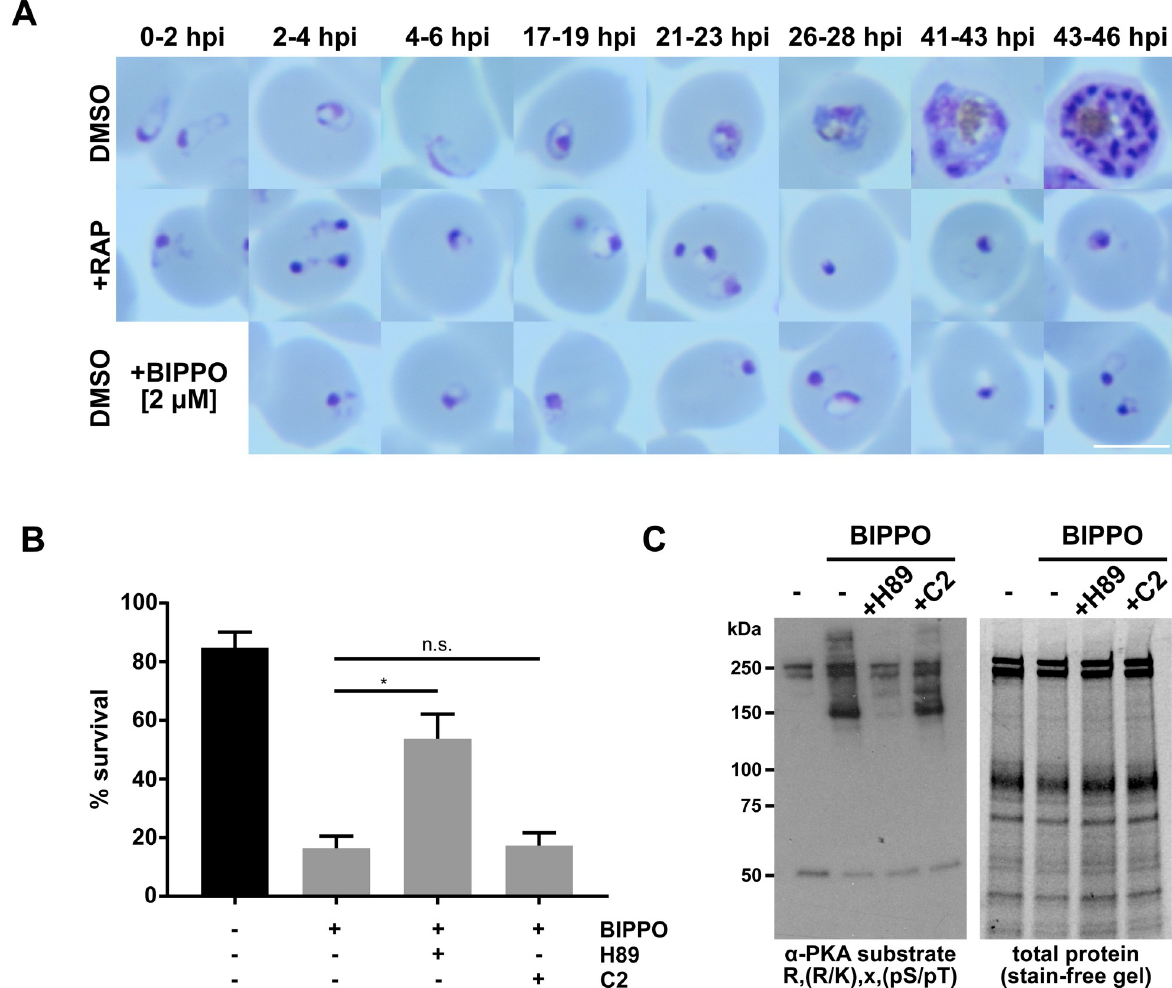
Fig 7. Prolonged PKA activity in newly invaded PfPDE β -null parasites blocks ring stage development. (A) The PDE inhibitor BIPPO phenocopies the PfPDE β -null post-invasion phenotype. Giemsa-stained blood films showing the morphology of PfPDE β Δ catHA parasites at different time points in cycle 1, following either mock or RAP treatment of the parasites in cycle 0, compared to mock-treated parasites exposed to the PDE inhibitor BIPPO immediately following invasion. (B) The PKA inhibitor H89, but not the PKG inhibitor Compound 2, rescues BIPPO-treated early ring stages. The plots were generated by microscopic analysis of Giemsa-stained smears from ring stage cultures (18–22 hpi) treated with the indicated compounds. Kinase inhibitors (H89 and C2) were added at 1–5 hpi and BIPPO at 2–6 hpi. Scale bar, 5 μ m. Data presented are mean counts (evaluated by three independent researchers) from two independent experiments, with > 100 parasites counted per condition. Error bars, SEM. � , significant by unpaired t test ( p -value = 0.0005); n.s., not significant ( p -value = 0.8508). (C) The PDE inhibitor BIPPO induces PKA- dependent phosphorylation in ring stages. Western blot of total protein from ring stages (12–16 hpi) treated for 90 minutes with various inhibitors: BIPPO (2 μ M), H89 (30 μ M), C2 (2 μ M). Lane 1 = no inhibitor control, lane 2 = BIPPO only, lane 3 = BIPPO + H89, lane 4 = BIPPO + C2. The blot was probed with an antibody to phosphorylated PKA substrate motif. The gel was stained for total protein prior to blotting to show equal loading (right panel). BIPPO, 5-Benzyl-3-isopropyl-1 H -pyrazolo[4,3- d ]pyrimidin-7(6 H )-one; hpi, hours post invasion; PDE, phosphodiesterase; PfPDE β , Plasmodium falciparum phosphodiesterase β ; PKA, cAMP-dependent protein kinase; pS/pT, phosphoserine or phosphothreonine; RAP, rapamycin; R/K, arginine or lysine.